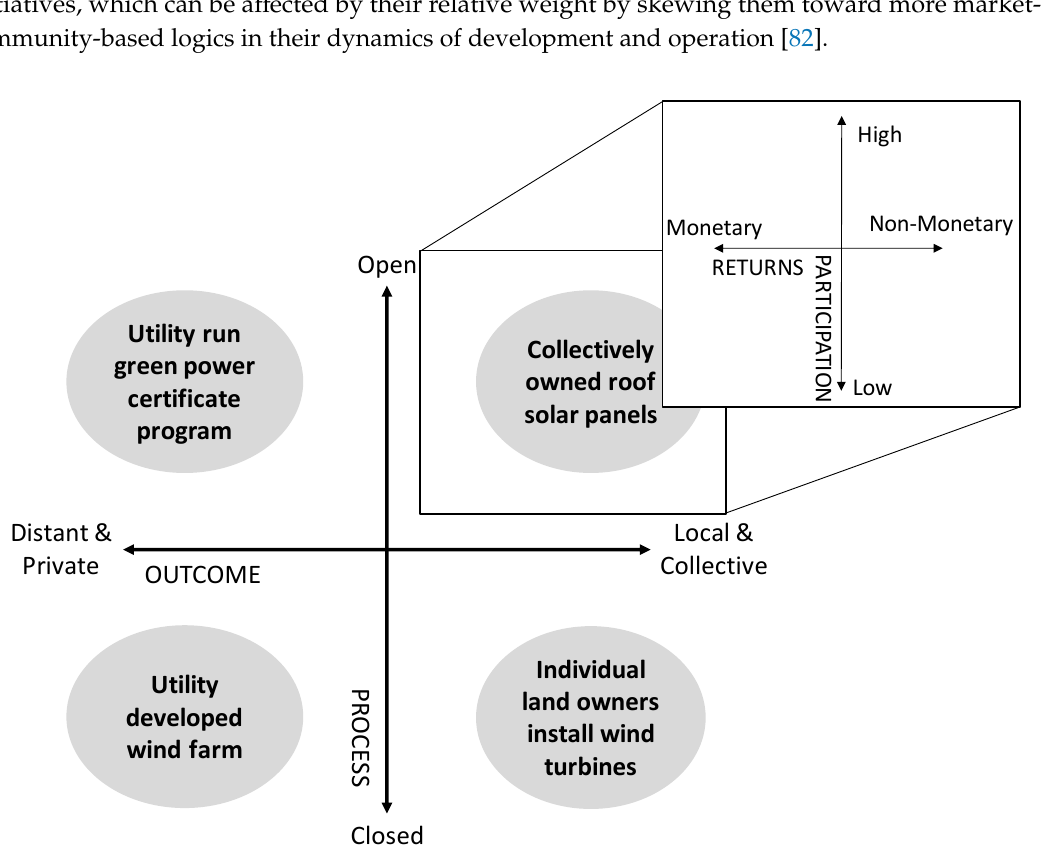
Figure 2. Community energy—two dimensions. Understanding of community renewable energy in relation to project process and outcome dimensions. Adapted from Devine-Wright [25] and Candelise and Ruggieri [82].